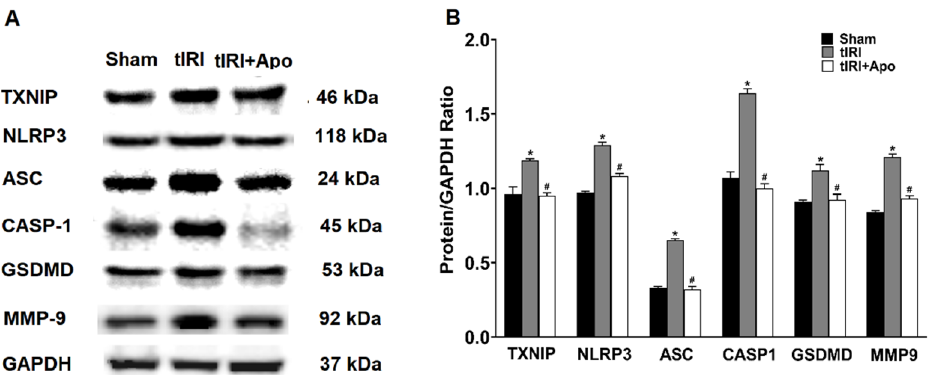
Figure 2. NOX promotes the protein expression of the NLRP3 inflammasome components during tIRI. ( A ) Western blot (WB) detection of NLRP3 proteins’ expression in ipsilateral testes of Sham, tIRI, and tIRI + apocynin (Apo) experimental groups. ( B ) Quantitation of WB band intensity is presented as protein/GAPDH ratio. Data are presented as mean ± SD ( n = 6/group), p -value < 0.05. * tIRI compared to sham and # apocynin-treated compared to tIRI.